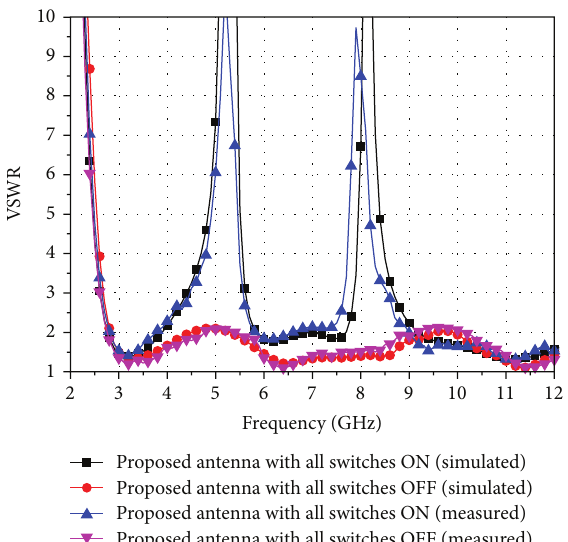
Figure 7: Comparison of the simulated and measured VSWR of the fabricated